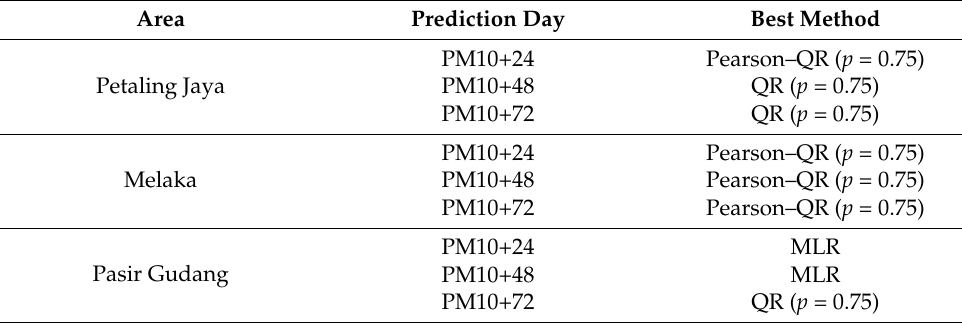
Table 9. Summary of the best prediction